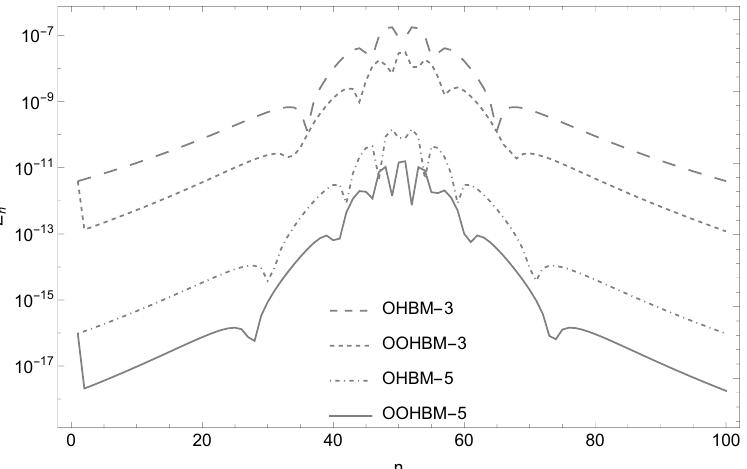
Figure 4. Maximum error profile for Example 1.